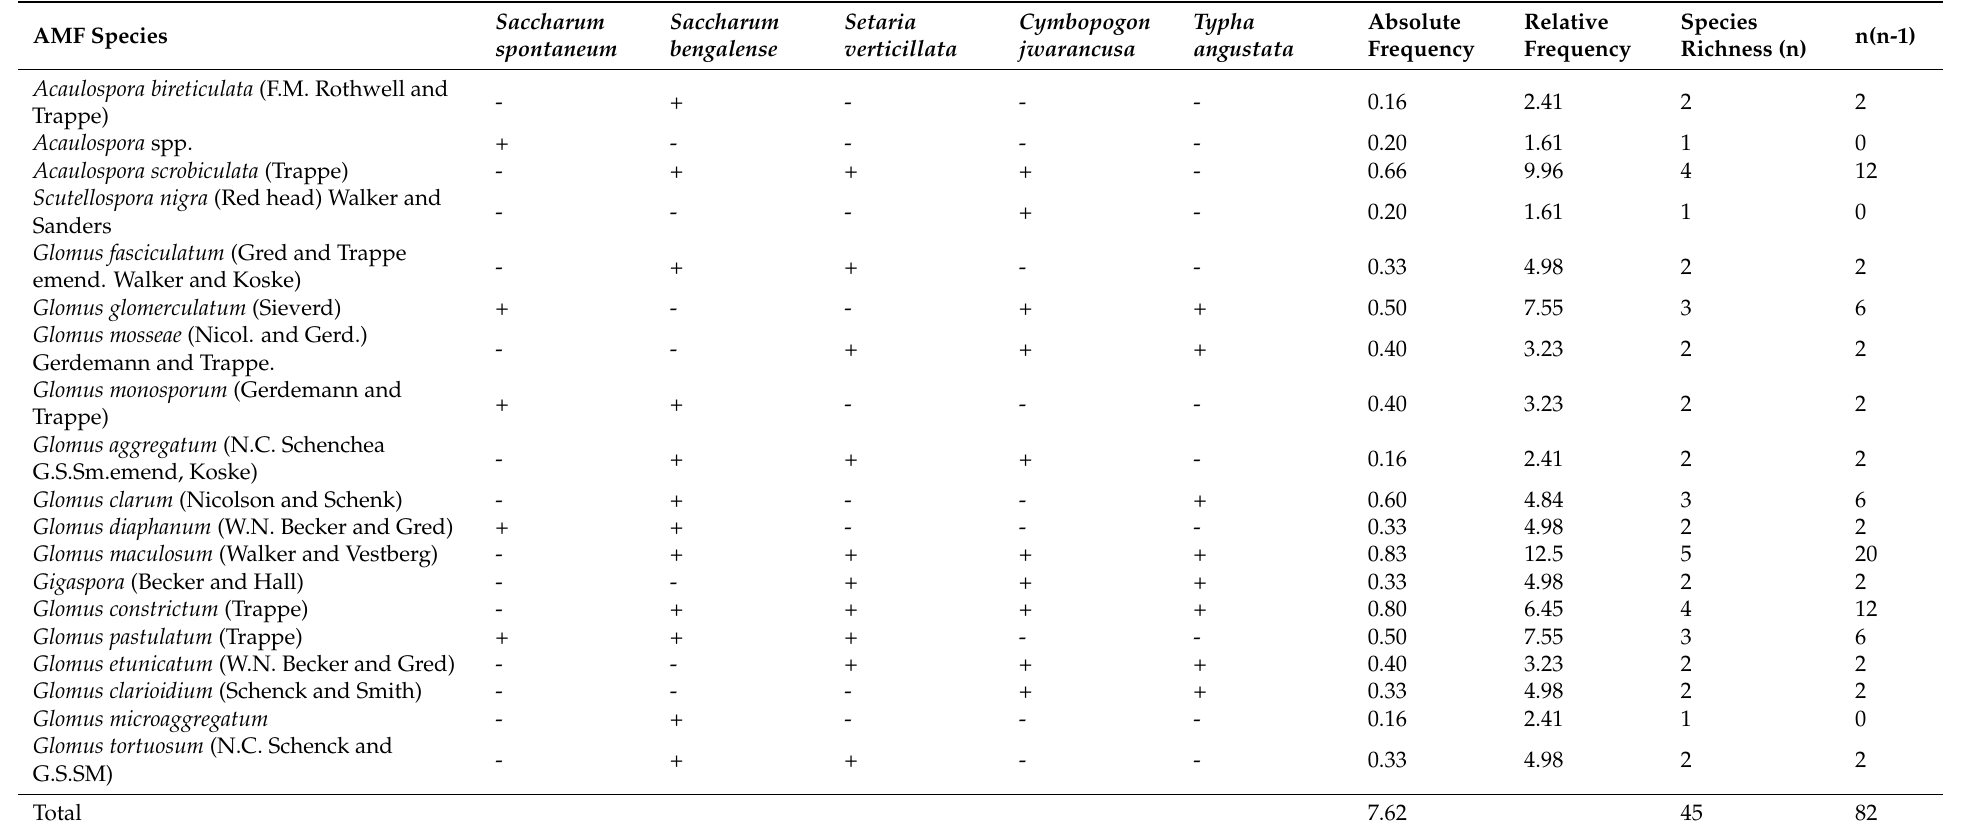
Table 3. Diversity of mycorrhizal spores in rhizospheric soil of trap cultured with Cenchrus ciliaris after